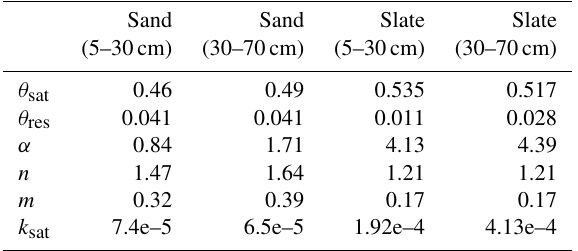
Table C1. Table of measured soil water retention curve parameters. Note: θ in m 3 m − 3 ; α in m − 1 ; k sat in ms − 1 .